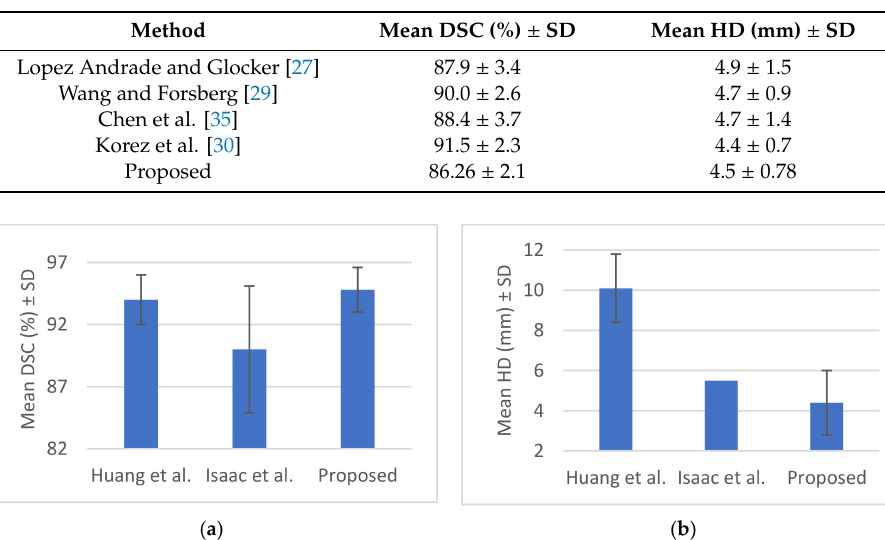
Table 3. MR image segmentation quality of the proposed method and state of the art.